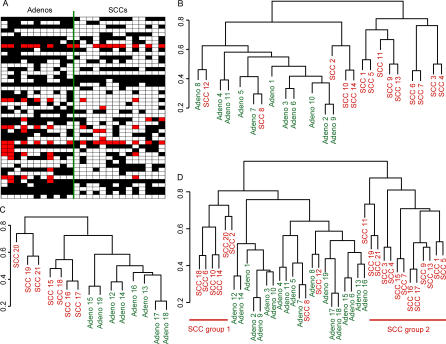
Aberrant DNA Methylation Profile and Cluster Analysis of Adenocarcinomas and SCCs of the Lung(A) DNA methylation patterns of the 47 RLGS fragments that distinguish adenocarcinomas from SCCs as recorded for the 25 primary tumor samples used to generate the cluster shown in (B). The adenocarcinoma and SCC sets are separated by a green line. Black boxes indicate DNA methylation; white boxes indicate absence of DNA methylation; red boxes indicate that the DNA methylation status of that RLGS fragment could not be determined. Each column represents a sample; each row represents an RLGS fragment.(B–C) Hierarchical clustering of adenocarcinoma and SCC samples. (B) Cluster comprising 25 samples (11 adenocarcinomas, 14 SCCs), based on 47 DNA methylation events. (C) Cluster comprising 15 samples (eight adenocarcinomas and seven SCCs), based on the DNA methylation information of the same 47 sequences as cluster (B).(D) Combined cluster from samples shown in clusters (B) and (C). SCCs groups 1 and 2 are underlined.